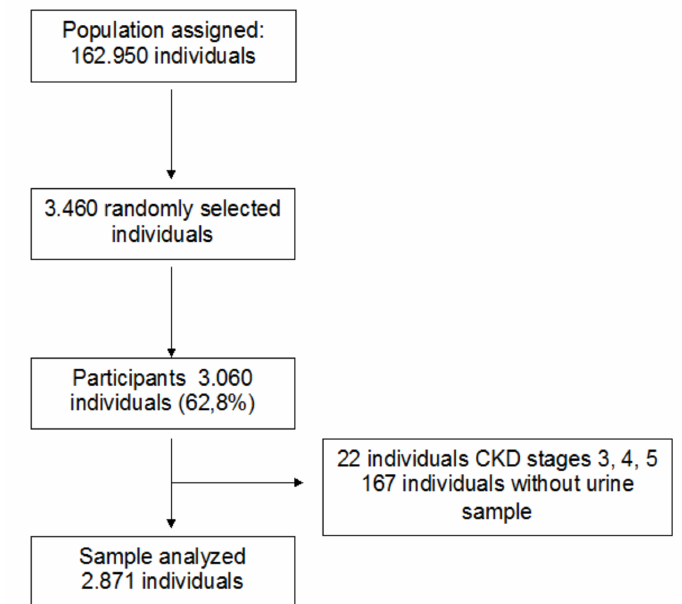
Figure 2. Diagram of